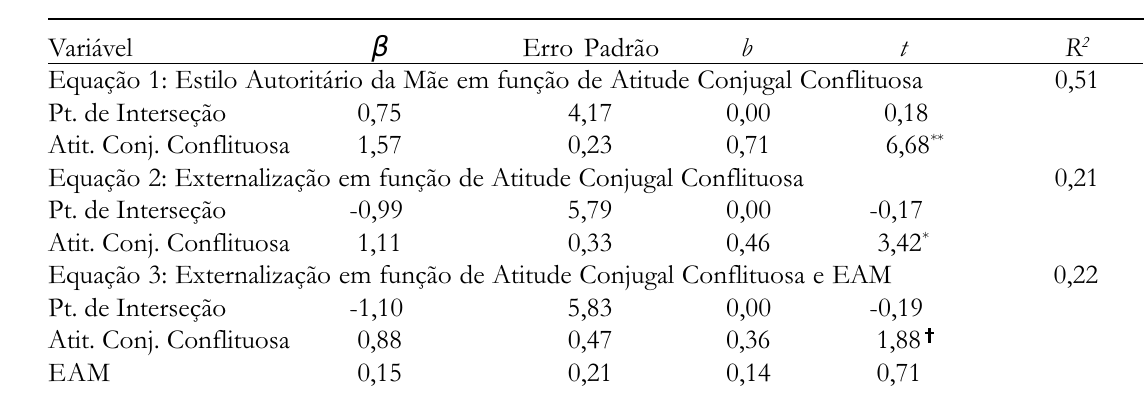
Tabela 4. Regressıes Mœltiplas: Teste da Media(cid:231)ªo do Estilo Parental AutoritÆrio da Mªe na Predi(cid:231)ªo